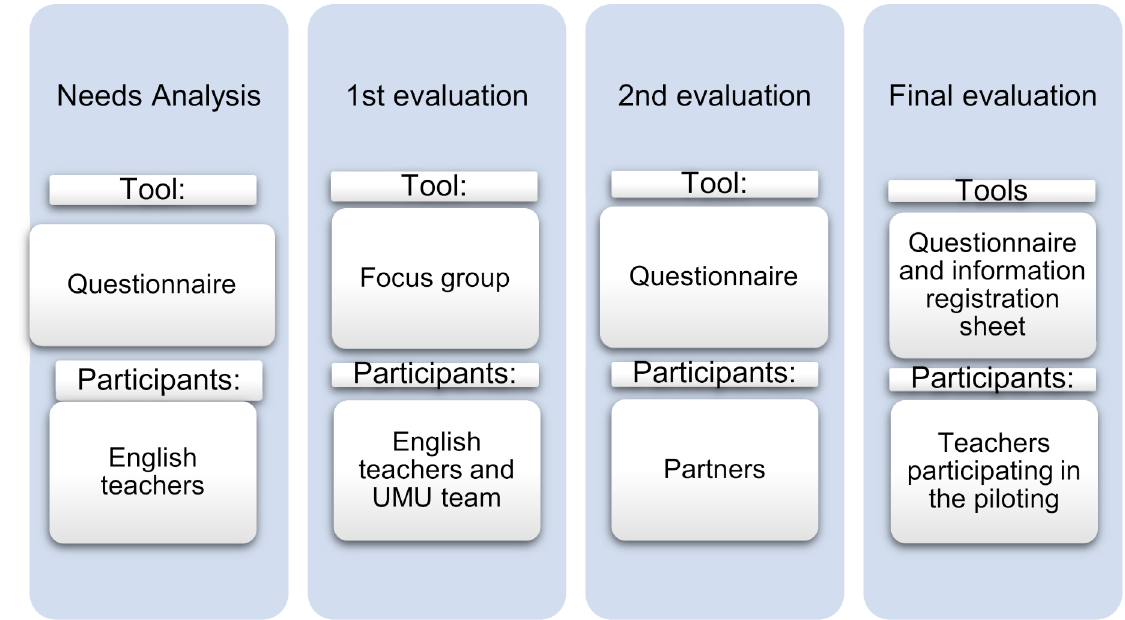
Figure 2. AROSE research process in four